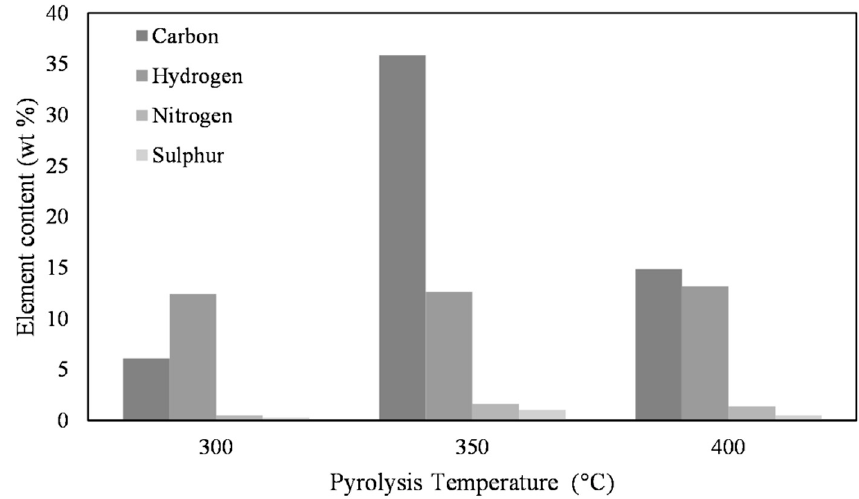
Figure 2. Temperature dependence of the element conversion of the pyrolysis of pure macroalgae into the liquid phase. The difference of the sum of the shown values for C, H, N, and S to 100% corresponds to the not-shown value for oxygen. Table 2. Properties of pyrolysis oils from the macroalgae Cladophora glomerata and the HDPE waste at 350 ◦